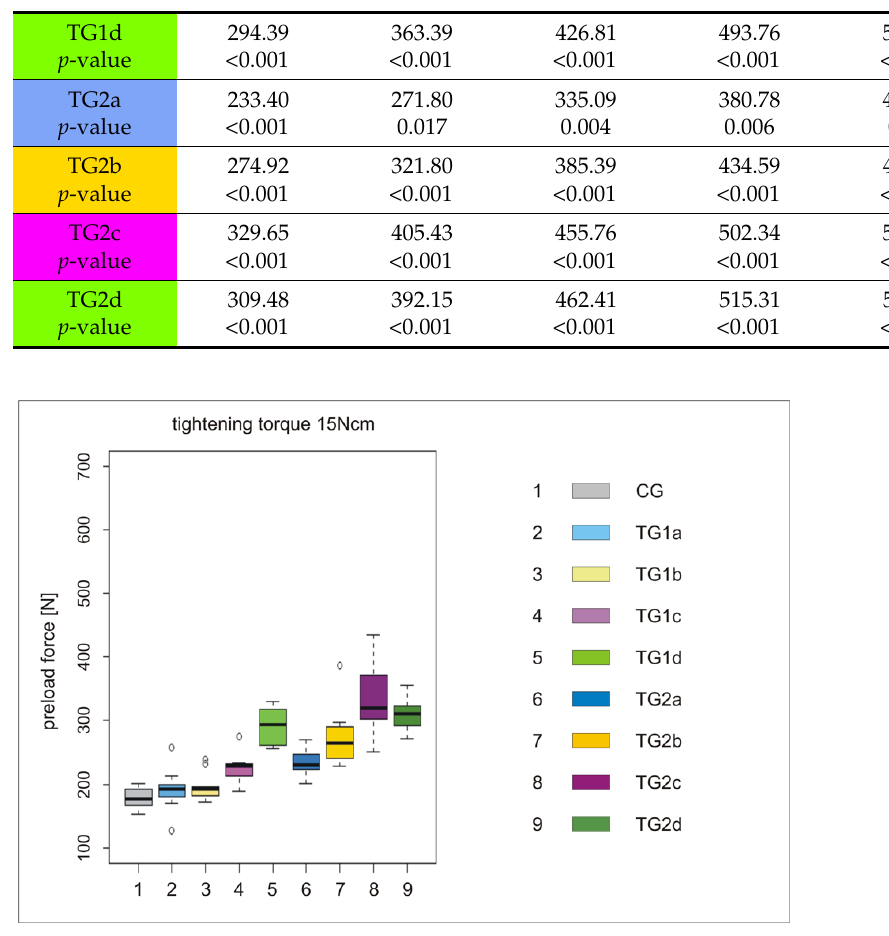
Figure 4. Boxplots of groups CG, TG1a – d, and TG2a – d with preload forces at a torque force of 15 Ncm, ( left ); a detailed legend of the x-axis ( right ).